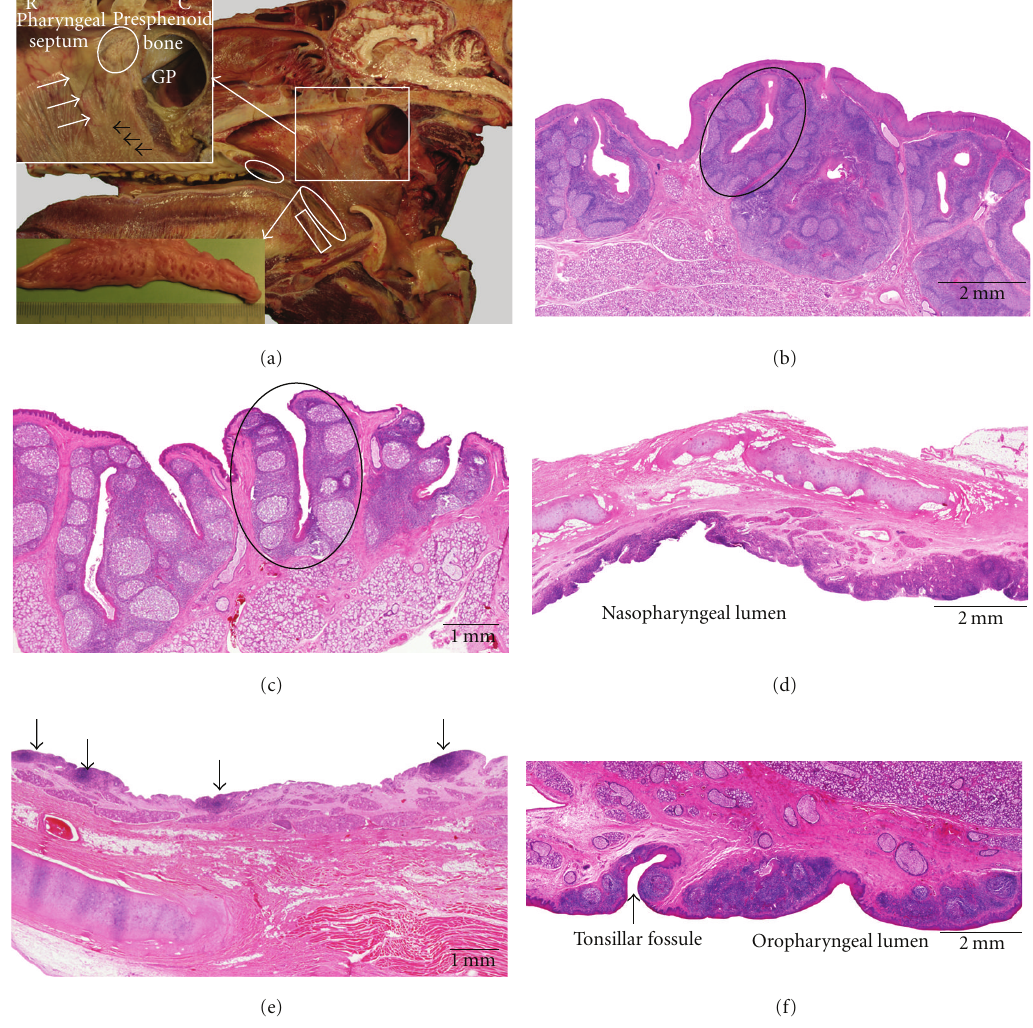
Figure 5: Anatomical localization and histological characteristics of the equine tonsils. (a) Median section through an equine head. The upper left insert shows the pharyngeal and tubal tonsils that are only visible after 4h fixation in 2% acetic acid. The encircled area in this insert represents the area of the pharyngeal tonsil. Caudoventral to the slit-like opening of the auditory tube (white arrows), numerous white nodules belonging the tubal tonsil (black arrows) can be observed (R: rostral, C: caudal, GP: guttural pouch). The tonsil of the soft palate at the oropharyngeal side of the soft palate (small encircled area), the lingual tonsil (boxed area), and the palatine tonsil (larger encircled area, detail shown in the lower left insert) are additionally illustrated. (b) Histological section through the lingual tonsil. (c–f) Histological sections through parts of the palatine (c), pharyngeal (d), and tubal (e) tonsils and the tonsil of the soft palate (f), respectively. Primary lymphoid follicles belonging to the tubal tonsil are indicated by arrows. Tonsillar follicles are encircled in (b) and